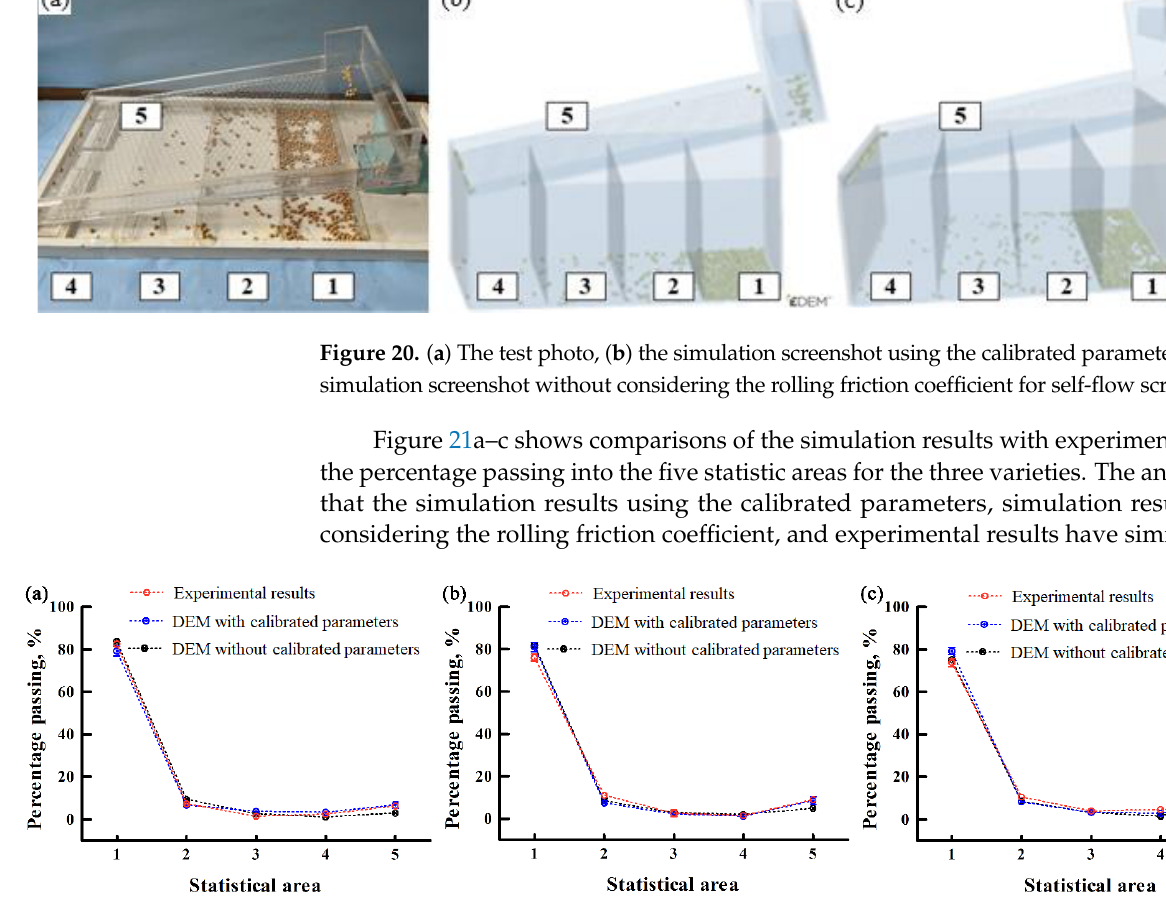
Figure 22. The percentage passing of the simulation and experimental results for three varieties. For the SN42, the simulation results using the calibrated parameter was slightly smaller than the experimental results, with a relative error of 0.7%. The difference be- tween the simulation results ignoring the rolling friction coefficient and experimental results was larger, with a relative error of 3.3%. For the JD17, the simulation results using the calibrated parameter was slightly smaller than the experimental results, with a relative error of 0.1%. The difference be- tween the simulation results ignoring the rolling friction coefficient and experimental results was larger, with a relative error of 4.9%. For the ZD39, the simulation results using the calibrated parameter was slightly larger than the experimental results, with a relative error of 0.27%. The difference be- tween the simulation results ignoring the rolling friction coefficient and experimental results was larger, with a relative error of 5.23%. Therefore, for the self-flow screening test, the simulation results using the calibrated parameters were closer to the experimental results. Through the comprehensive analysis of the simulated and experimental results of the rotating cylinder test and self-flow screening test, our results showed that, for the three varieties of soybean seed particles, the simulation results using calibrated parame-